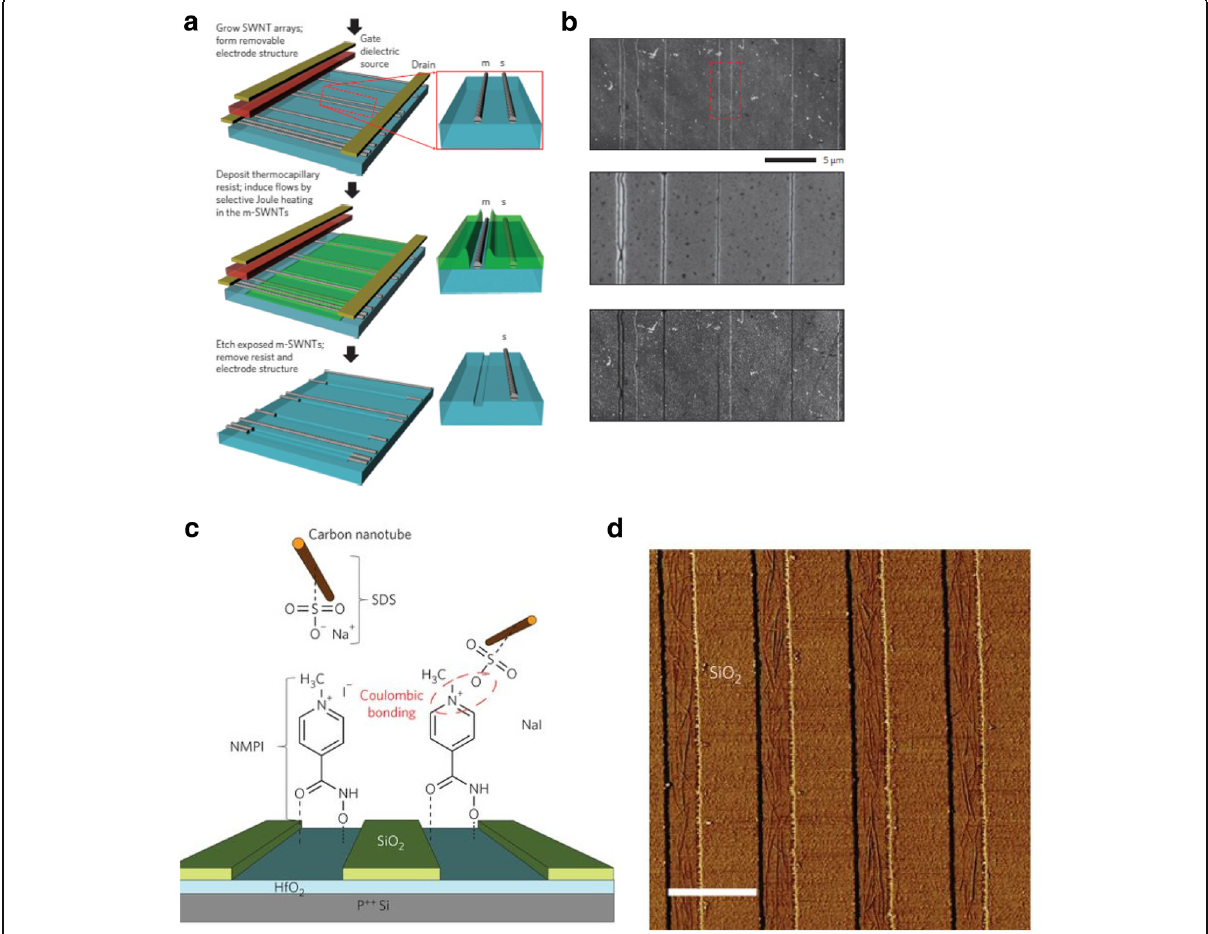
Fig. 43 a Schematic illustration of steps involved in selective removal of metallic CNTs using thermocapillary effects. Adapted from [285]. b Corresponding AFM images of each step starting from growth of SWCNT arrays, followed by deposition of thermocapillary resist and etching of metallic SWCNTs. Adapted from [285]. c Schematic of the deposition of well-aligned CNTs on HfO 2 by means of the ion exchange process. Adapted from [286]. d Corresponding AFM image of the nanotubes deposited on a HfO 2 trench with a width of about 200 nm. Adapted from